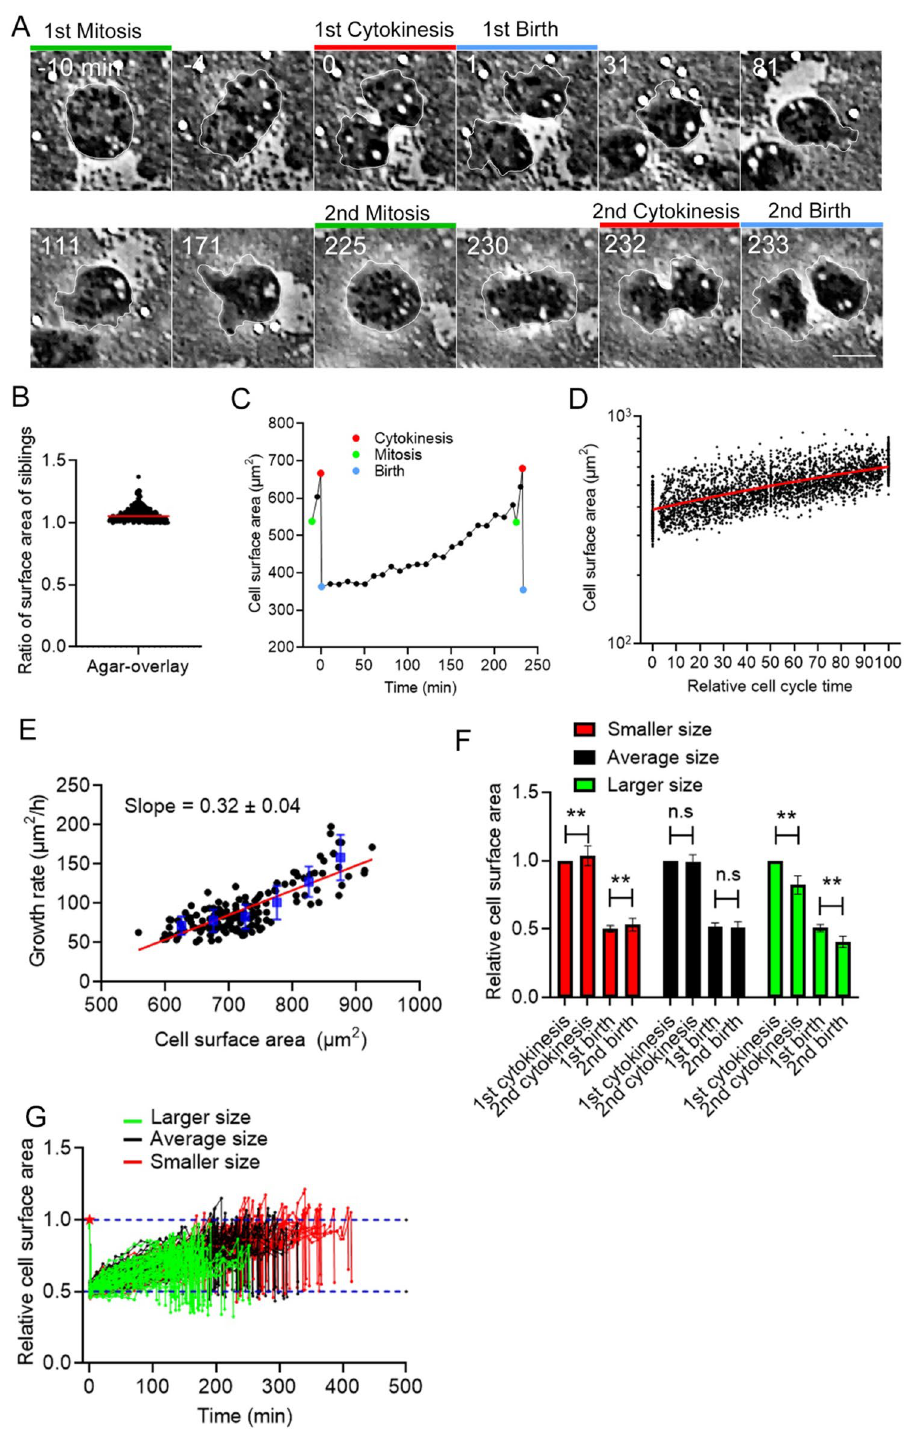
Figure 1. Control of the total cell surface area in a whole cell cycle. ( A ) Time course of phase-contrast images of Dictyostelium cells in a whole cell cycle. The green lines show the mitotic phase, the red lines show cytokinesis, and the blue lines show the cells immediately after cell division (at birth). The cell was outlined with white lines. Scale bar, 10 μm. ( B ) Ratios of the surface area between sibling cells (larger cells/ smaller cells) The cells divide almost evenly with a small deviation (7.02% ± 5.94%, n = 227). ( C ) Representative time course of the total cell surface area in a whole cell cycle. The colored marks indicate the same events shown in ( A ). ( D ) Time courses of total cell surface area in the logarithmic scale from birth (0) until immediately before the next mitosis (100) in multiple cells (n = 147). The relative cell cycle time (only interphase) is normalized. The red line shows a result by linear regression. ( E ) The instantaneous growth rate versus the cell surface area immediately before cytokinesis. The blue vertical lines show the binned mean ± SD. A linear regression line is shown in red, which supports the exponential growth of cell surface area. ( F ) Comparison of the relative cell surface area between the 1st and 2nd cytokinesis and at the first and second birth in larger (> 450 µm 2 , green), average (400 ± 50 µm 2 , black), and smaller sized cells (< 350 µm 2 , red). Data are presented as the mean ± SD. **P < 0.001; ns, not significant; P > 0.05. ( G ) Time courses of the relative cell surface area of individual cells from the first division (red asterisk) to the second division (n = 147). The blue dotted lines show 0.5 and 1.0 of the relative cell surface area,